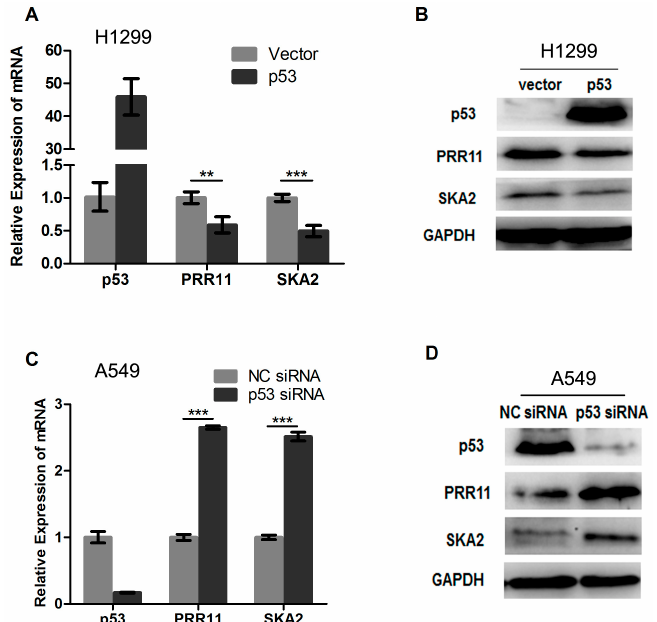
Figure 2. p53 represses endogenous PRR11-SKA2 transcription. ( A , B ) Exogenous overexpression of p53 represses endogenous PRR11 and SAK2 expression. H1299 cells ( p53 -deficient) were transiently transfected with the empty and p53 expression vectors. Forty-eight hours after transfection, total RNA and whole cell lysates were prepared and subjected to qRT-PCR and Western blotting analyses. GAPDH was used as an internal control; ( C , D ) Knocking-down endogenous p53 expression causes upregulation of PRR11-SKA2 . A549 cells carrying wild type p53 were transiently transfected with negative control (NC) or p53 specific siRNAs. Forty-eight hours after transfection, cells were harvested, and total RNA and cell lysates were prepared and subjected to qRT-PCR and Western blotting analyses. ** p < 0.01, *** p < 0.001.